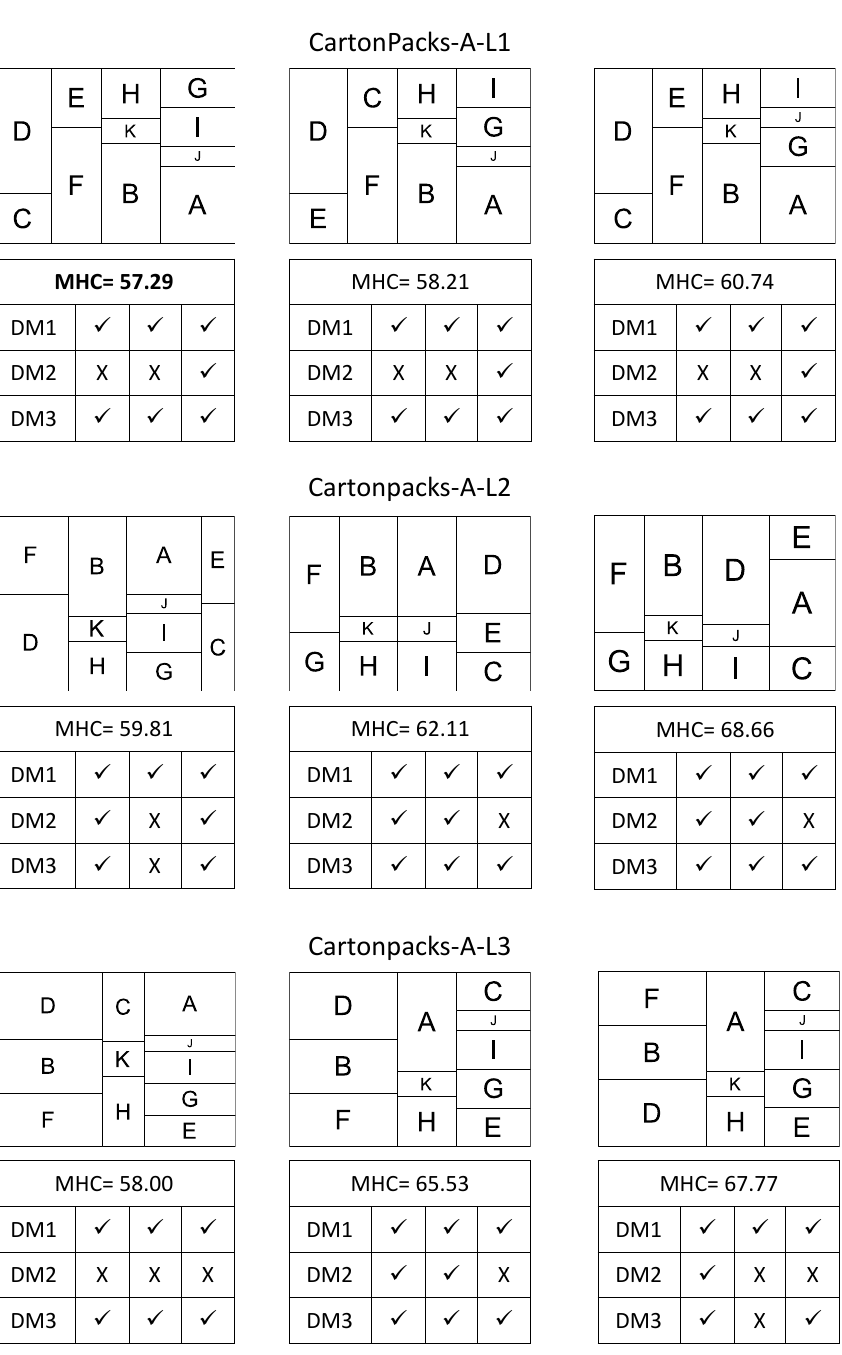
Figure 11. Best solutions found in Alternative launch 1 to 3 of CartonPacks